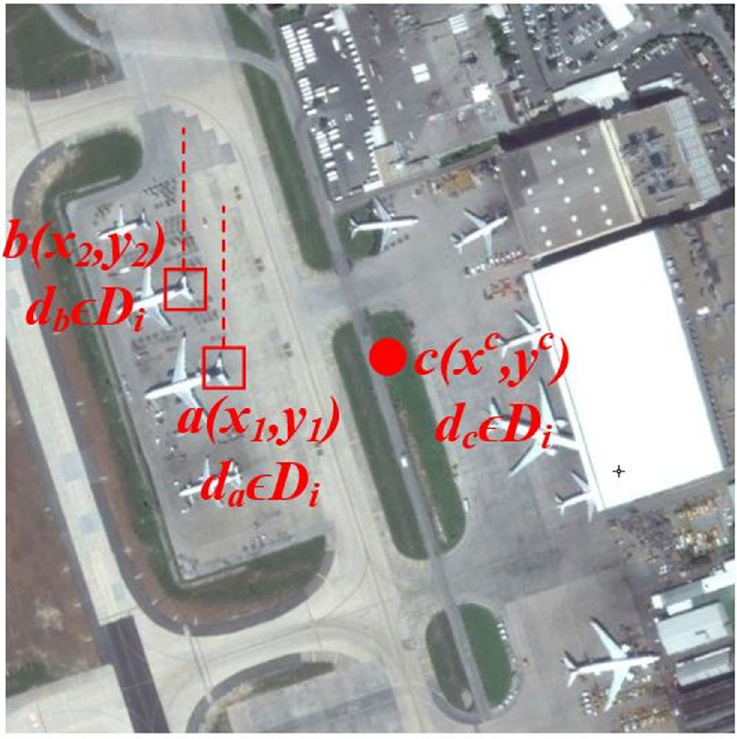
Fig 3. Spatial coordinate representation relative to the geometric center for identical visual